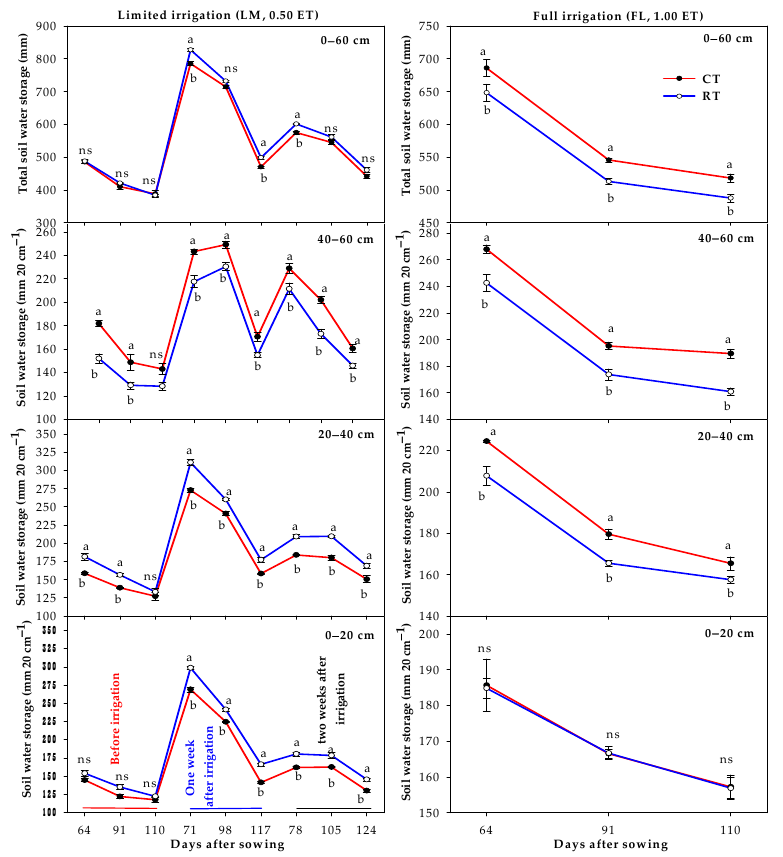
Figure 2. Comparison of soil water storage before irrigation, one week after irrigation, and two weeks after irrigation between conventional tillage (CT) and reduced tillage (RT) practices at different soil depths under limited (LM) and full irrigation (FL) regimes. Bars with different letters are significantly different from each another on the basis of Duncan’s multiple range test at p ≤ 0.05.